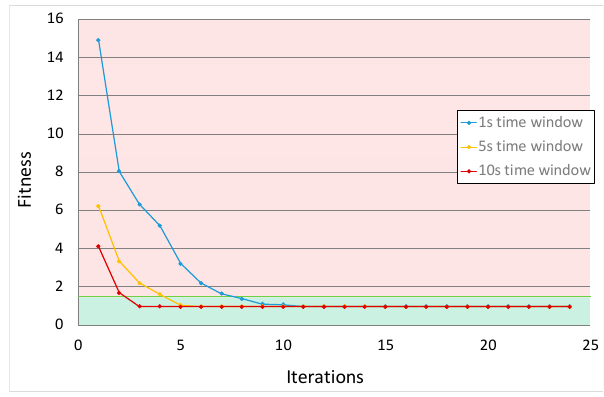
Figure 6. Evolution of the mean value of the fitness of the best solution found by the Differential Evolution (DE) algorithm for the case of one intermediate timing point.